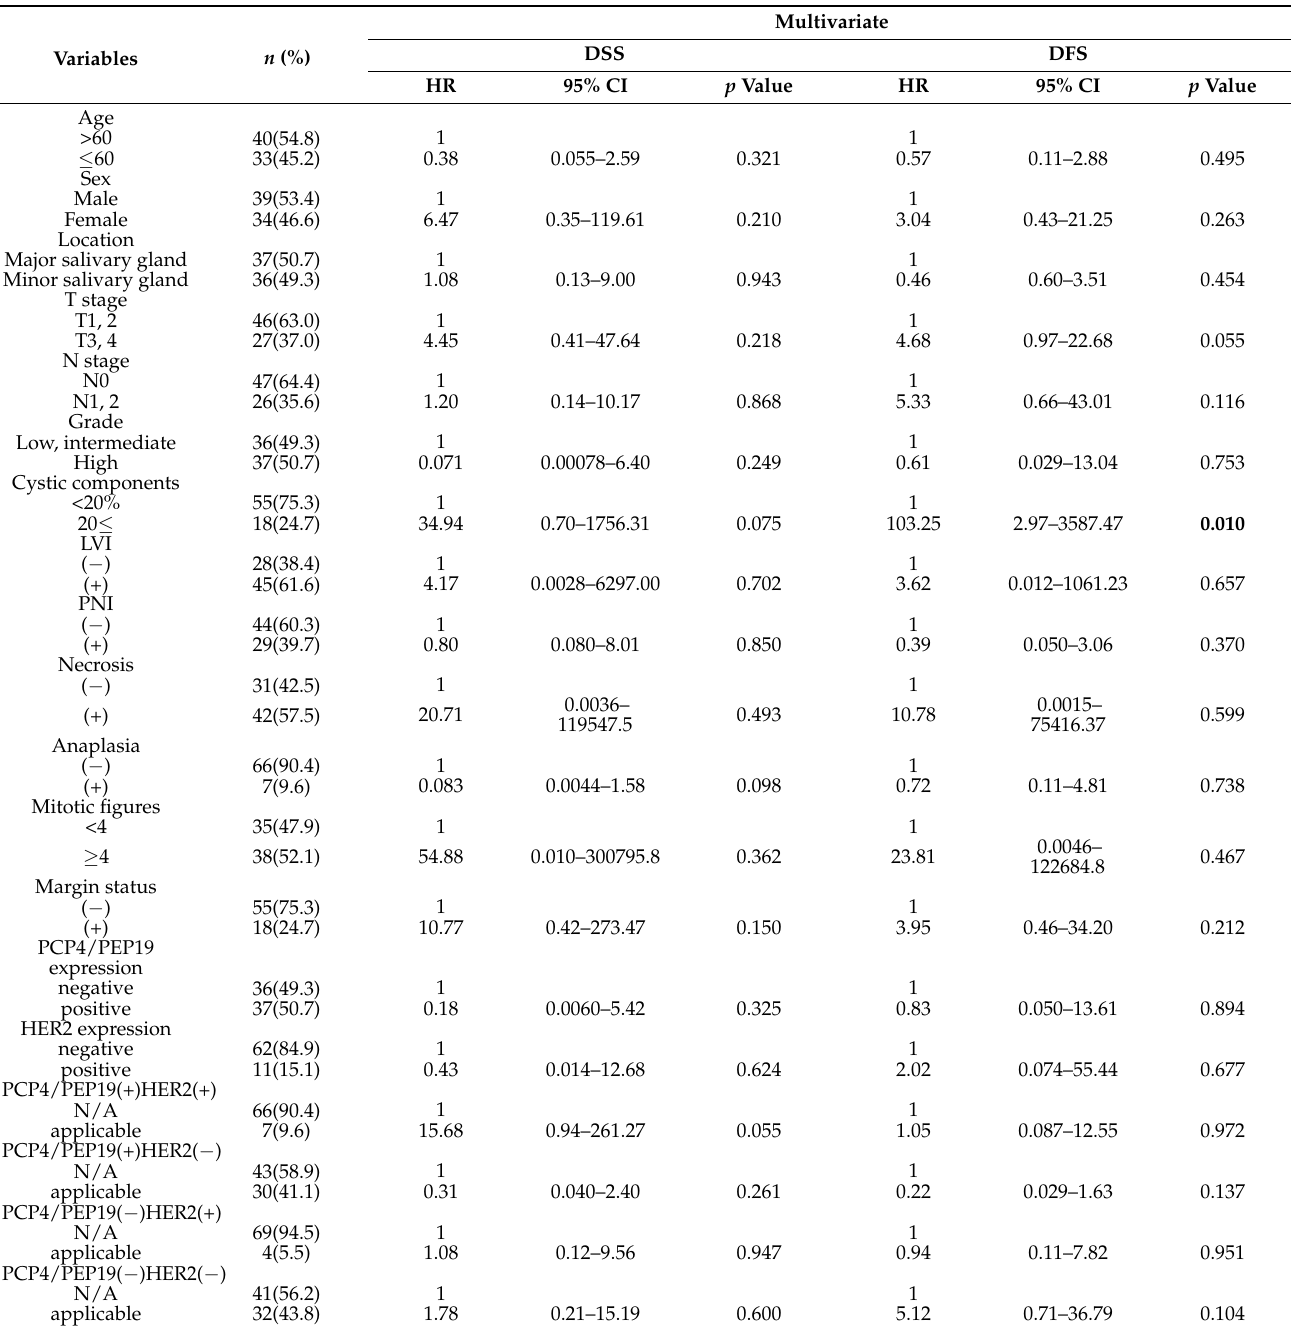
Table 4. Multivariate Cox proportional hazards analysis of clinicopathological variates and predictors of DSS and